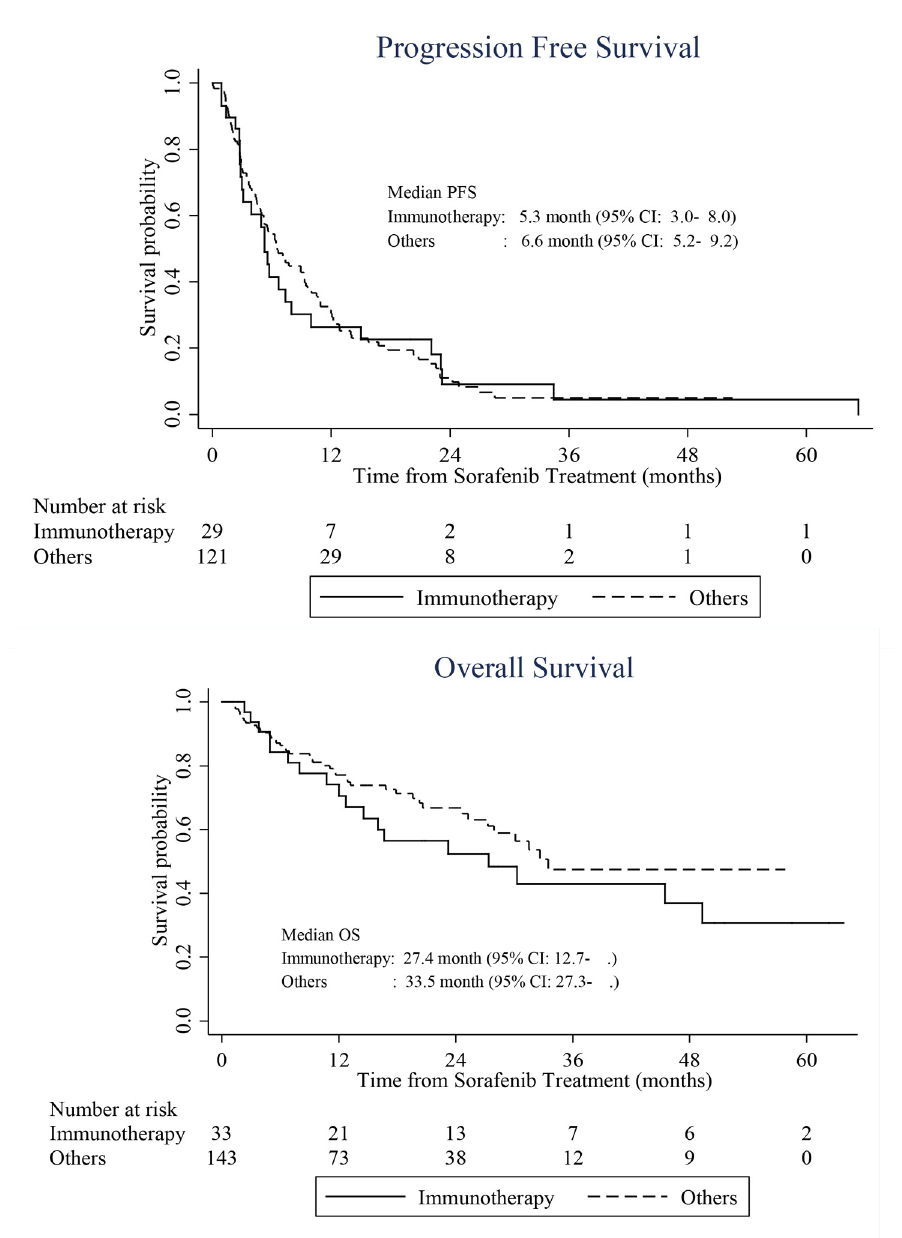
Fig 2. Comparison of progression-free (PFS) and overall survivals (OS) after sorafenib treatment between immunotherapy-refractory (N = 33) and non-immunotherapy patients (N = 144). CI, confidence